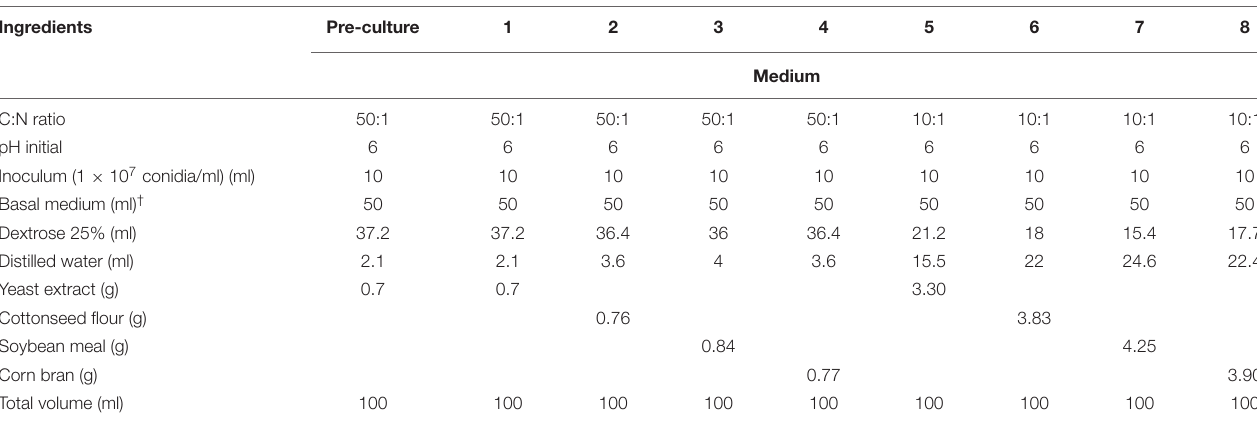
TABLE 1 | Composition of liquid culture media used in submerged liquid fermentation of C. rosea (strain CMAA1284).